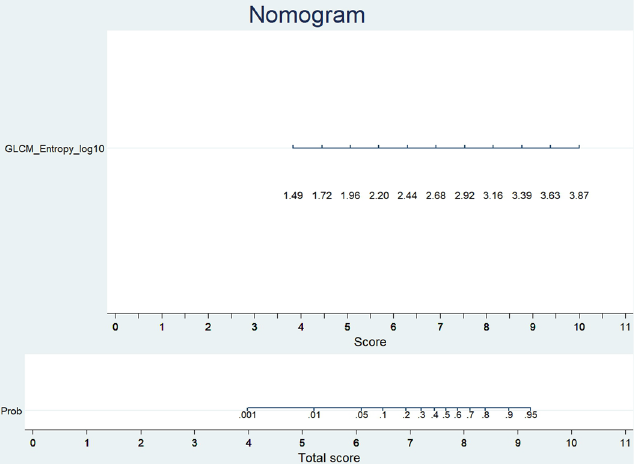
Figure 4. Nomogram to predict the possibility of invasive pulmonary adenocarcinoma lesions based on GLCM-based feature (GLCM_Entropy_log10). To use the nomogram, an individual participant’s value is located on each variable axis, and a line is drawn upward to determine the number of points received for each variable value. The sum of these numbers is located on the total points axis to determine the possibility of invasive pulmonary adenocarcinoma lesions.